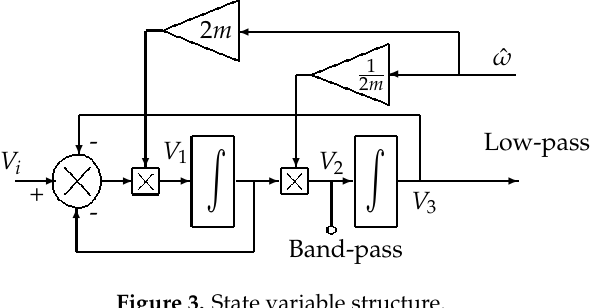
Figure 3. State variable structure.